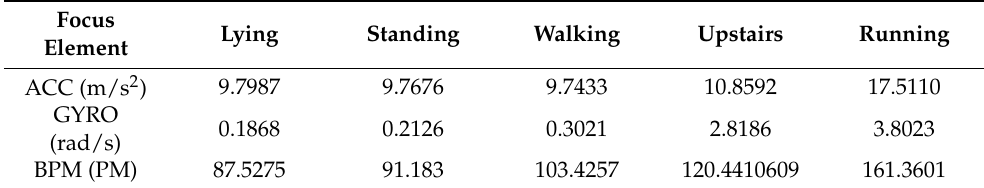
Table 3. Behavior parameter feature table.